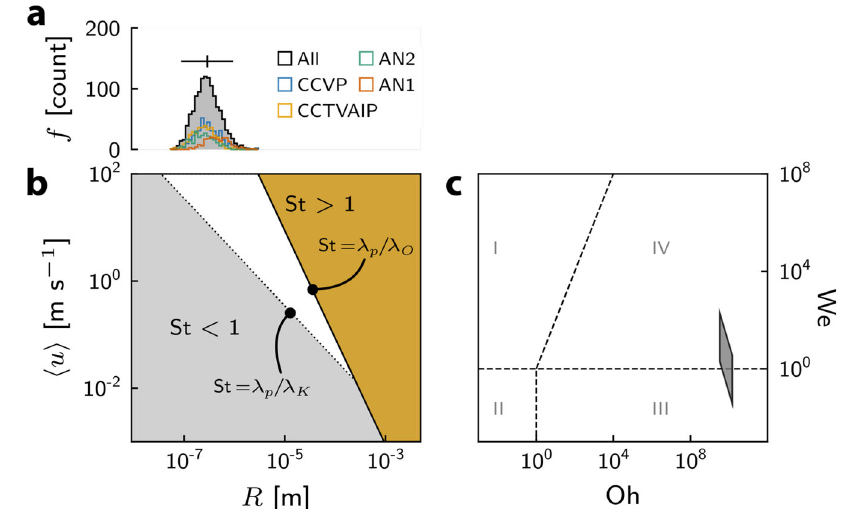
λ – Ohnesorge plane for the range of particle fl ow ( λ O and K , respe c tively). c Weber sizes, droplet density, surface tension, viscosity, and velocity (see text). The four regimes are: I (inertial impact – driven); II (inertial capillary – driven); III (viscous capillary – driven); IV (viscous impact – driven) 43 . At u h i ~100 ms − 1 , We ≫ 1; at u h i ~10 ms − 1 ,